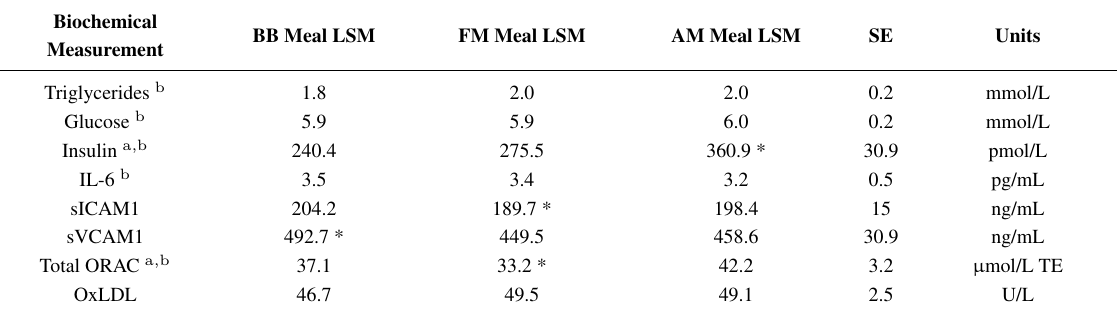
Table 3. Postprandial Responses of Biochemical